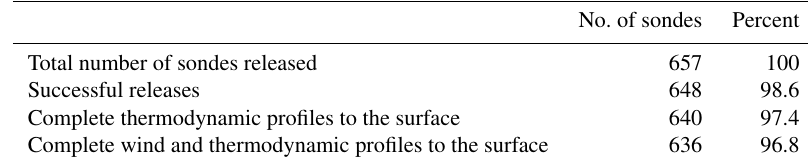
Table 2. Overview of the dropsonde system